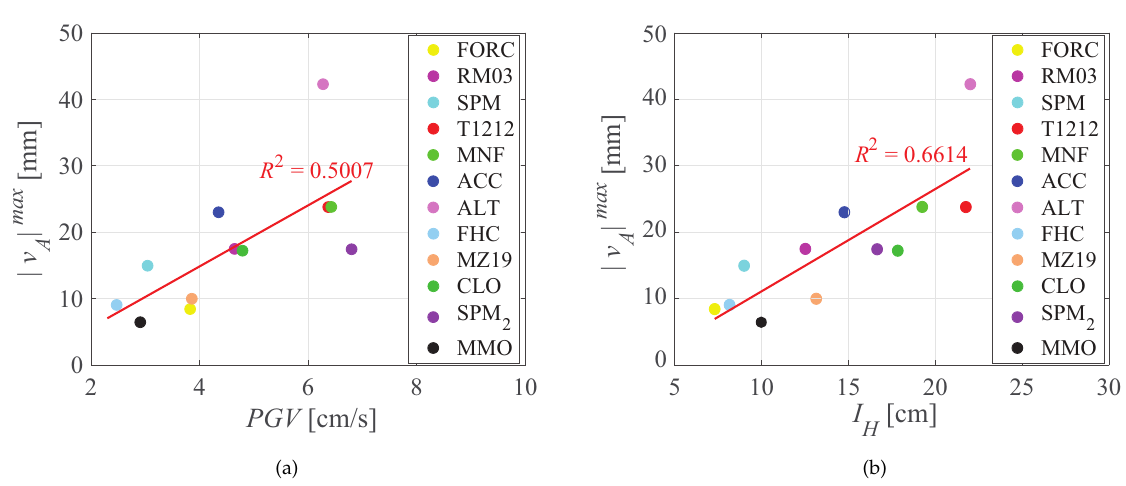
Figure 25. Individual events: correlations between maximum displacement response | v A | max and ( a ) PGV , ( b ) Housner intensity I H